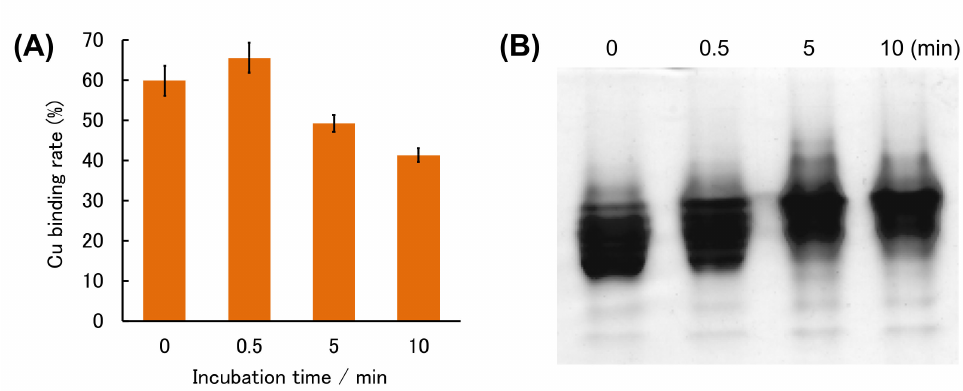
Figure 6. ( A ) Cu binding rate of (E,E)-H43R with one equivalent of Cu 2 + during incubation at 50 ◦ C in phosphate bu ff er. Error bars are SE ( n = 3). ( B ) Native-PAGE of (E,E)-H43R with one equivalent of Cu 2 + in phosphate bu ff er after the indicated incubation times.